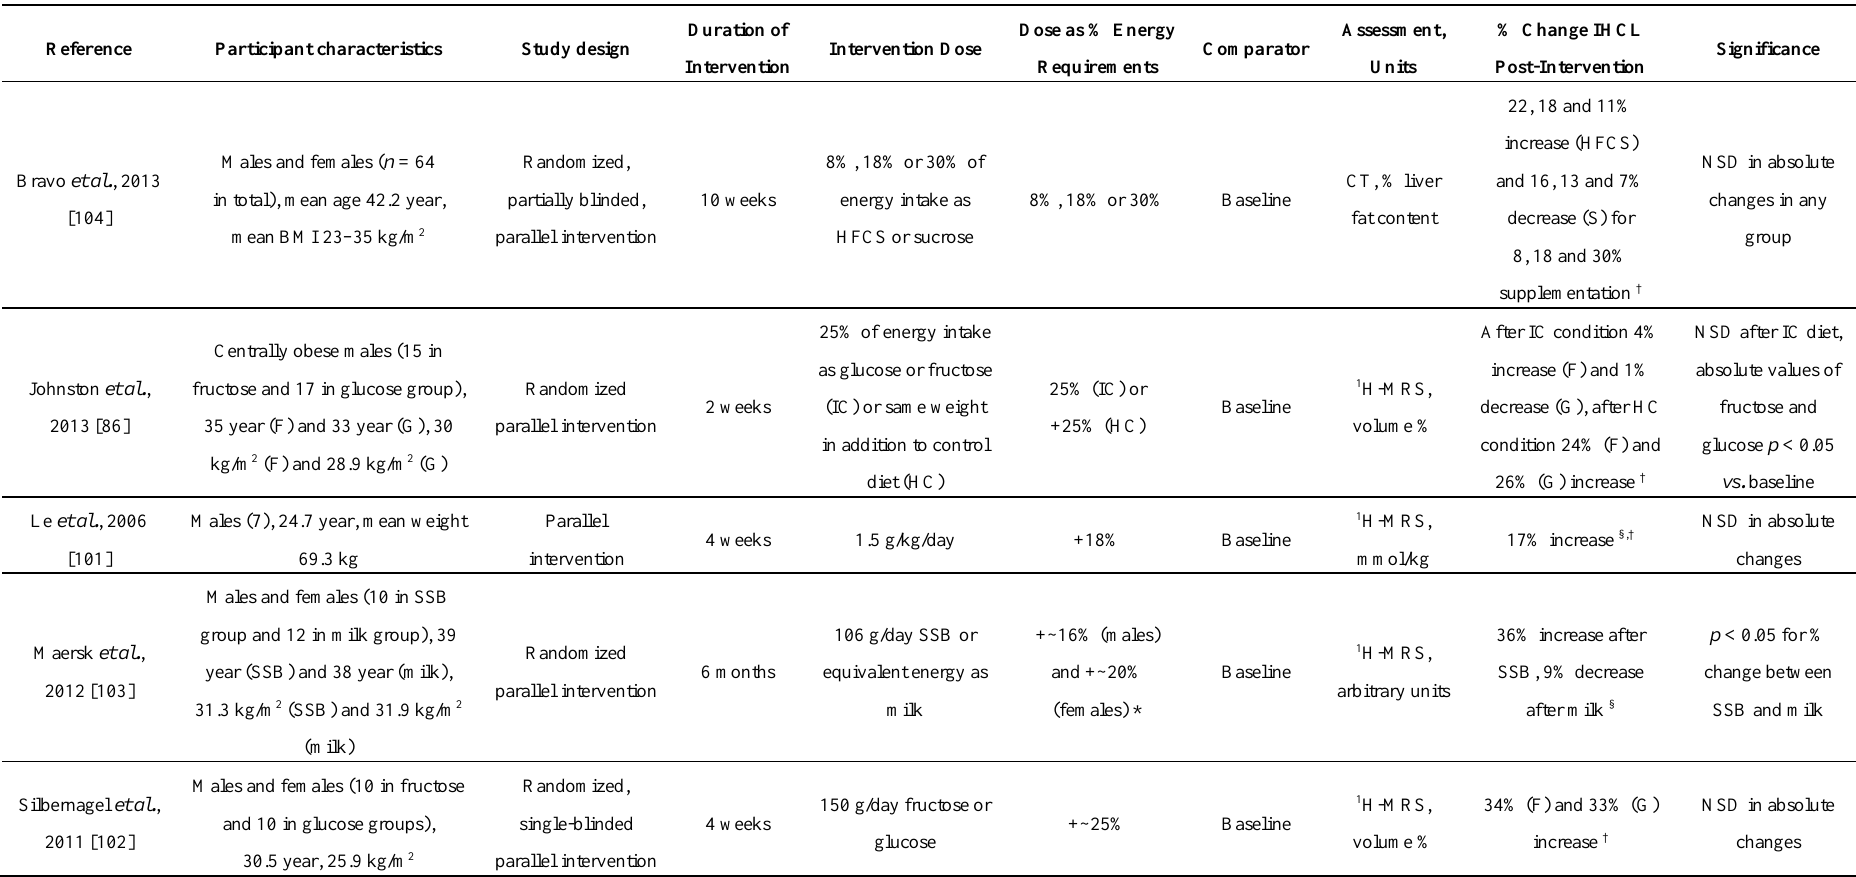
Table 2. Summary of study characteristics of long-term monosaccharide feeding trials and IHCL